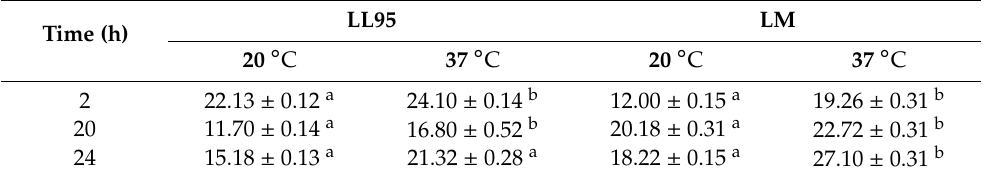
Table 2. Autoaggregation (%) of Lactococcus lactis subsp. cremoris LL95 and Listeria monocytogenes ATCC 7644 during di ff erent incubation periods and temperatures.